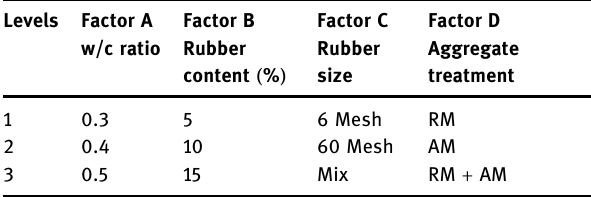
Table 7: Factors and levels used in the